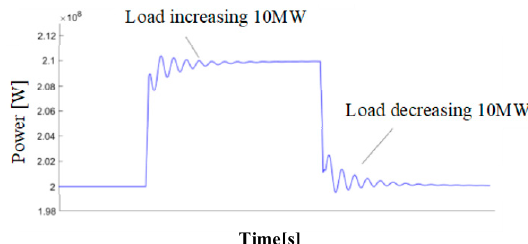
Figure 9. The deduced output of the hydropower model.